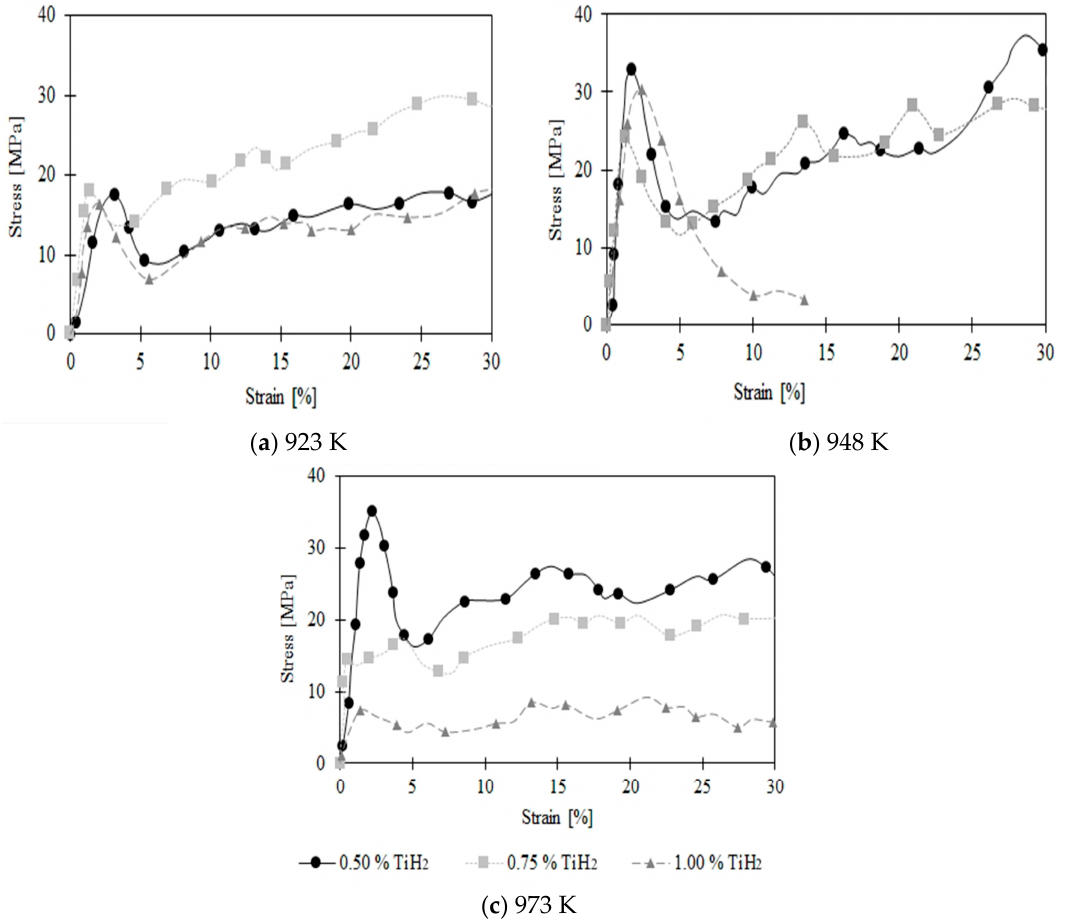
Figure 6. Effect of the percentage of TiH 2 and temperature on the mechanical behavior of A-242 aluminium alloy foams, ( a ) 923 K, ( b ) 948 K, ( c ) 973 K.